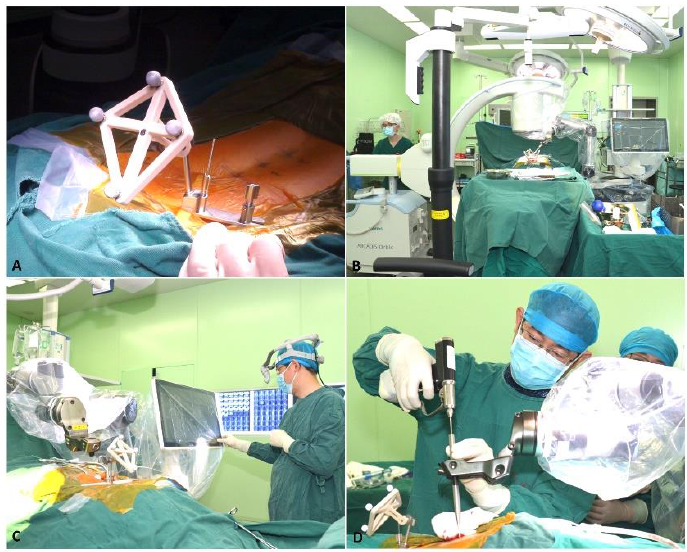
Figure 3. Securing the tracker ( A ), scanning ( B ), planning ( C ), and drilling the K-wire ( D